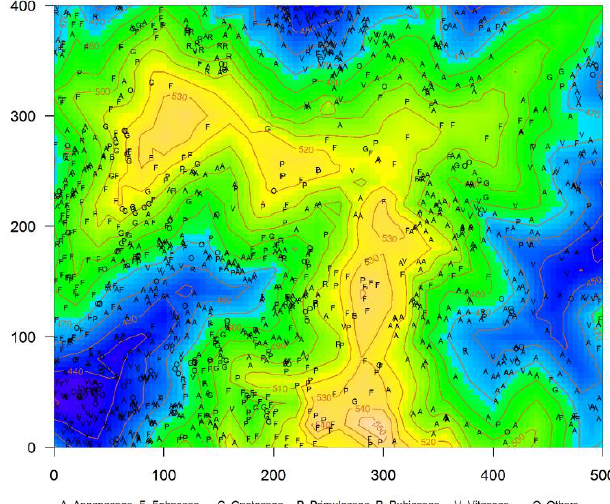
Figure 1. The distribution of liana individuals in a 20 ha subtropical forest dynamic plot in Chebaling (CBL), China. Color and numbers on the contour lines denote elevation. Capital letters show the locations of lianas and indicate their families.